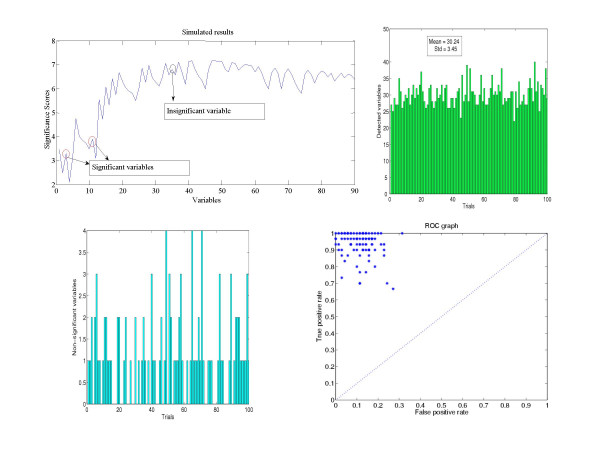
The hot-spot is detected by the HOTTOR algorithm. Upper panel, data are generated according to the covariance matrix Eq. (1). Bottom panel, hot-spots detected by HOTTOR with randomly generated covariance matrices. A total of 100 trials are tested and Bottom panel right depicts the variables wrongly picked by the algorithm.